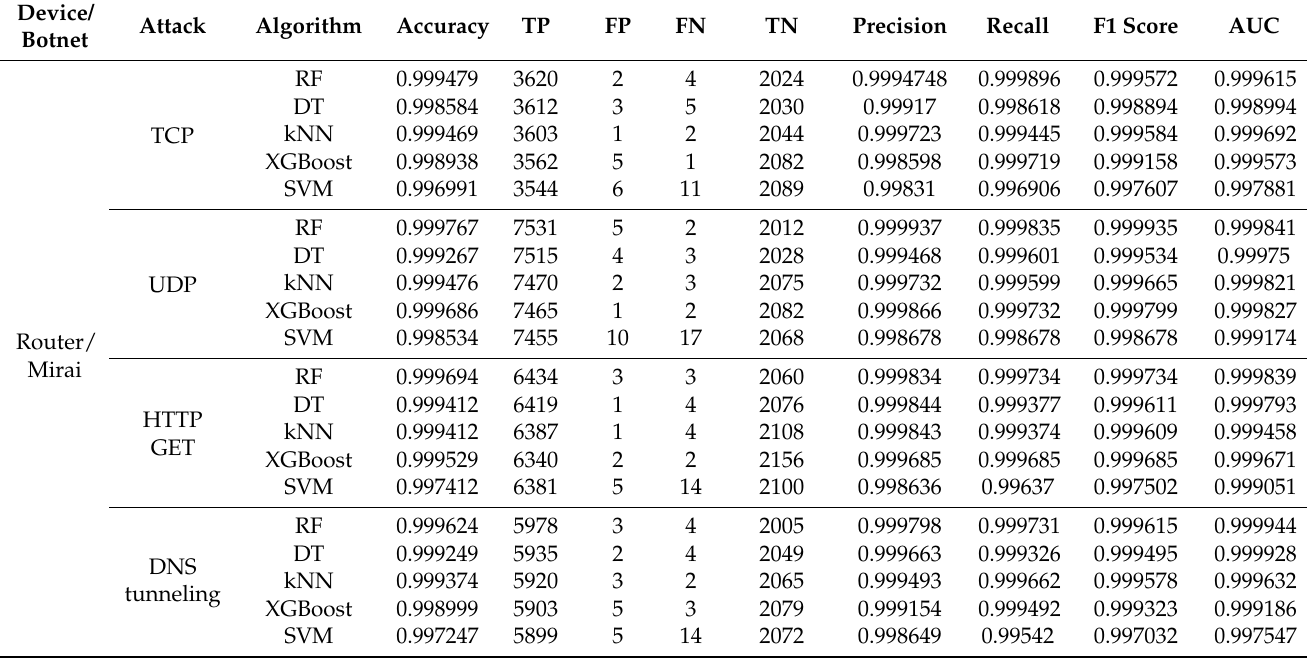
Table 11. Classification results